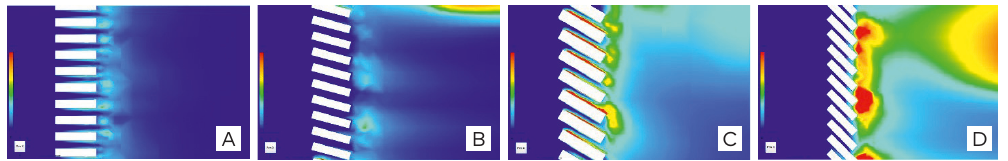
Figure 13. Energy growth per area of barrier with 30 mm thickness of mineral